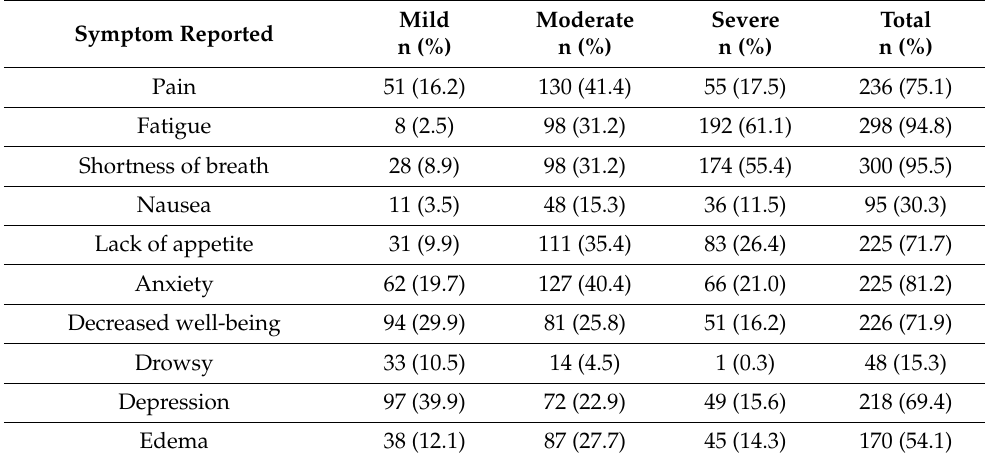
Table 2. Symptom reported using Edmonton Symptom Assessment Scale (n = 314).